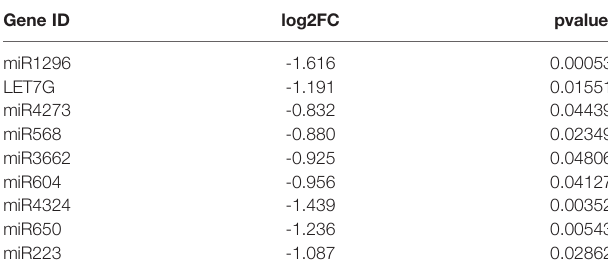
TABLE 1 | Differential expression of miRNAs in 18 osteosarcoma bone samples and 18 paired normal bone